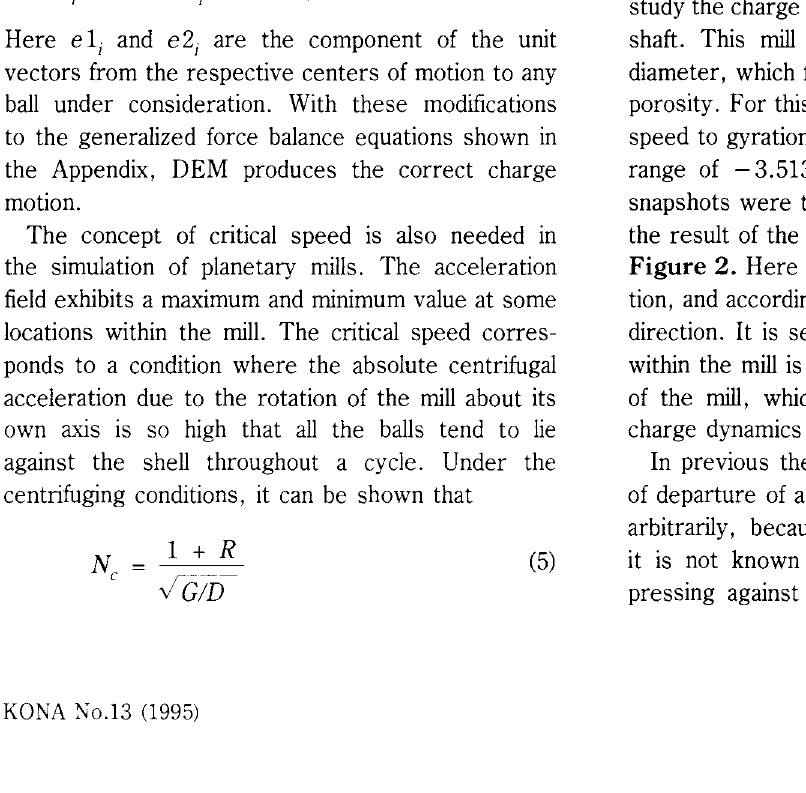
Fig. 2. Charge motion inside a planetary mill; R =